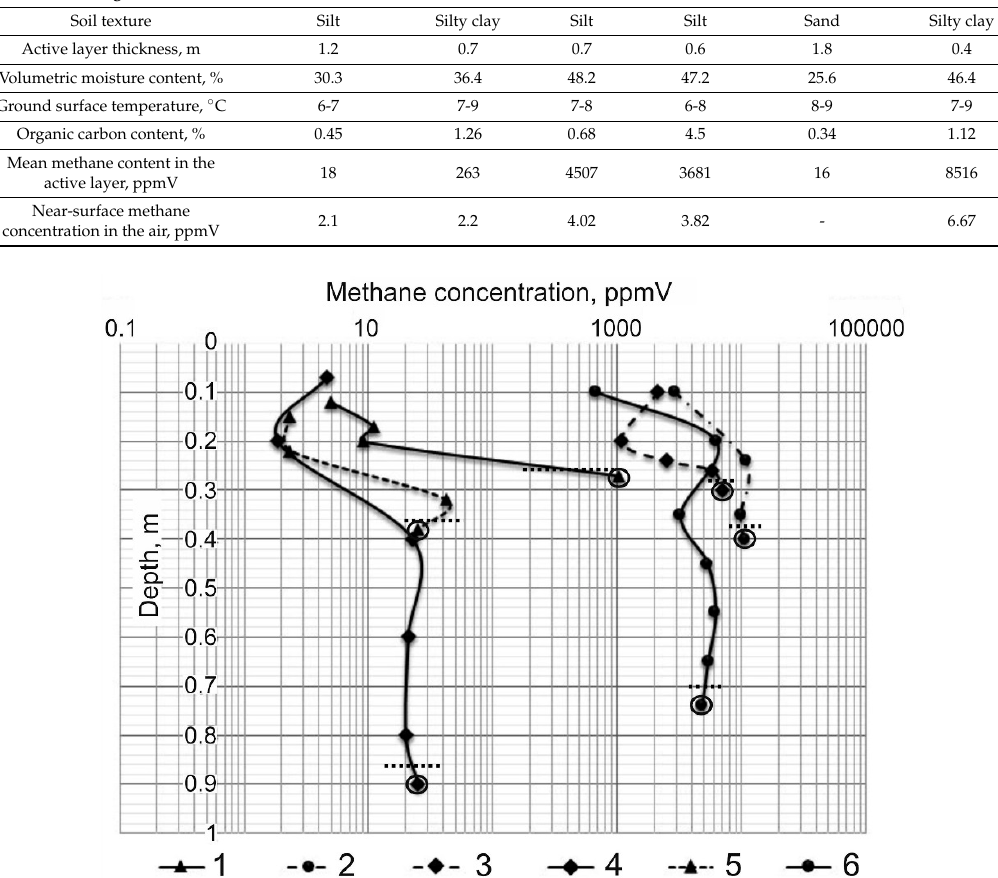
Figure 4. Methane content in the active layer and upper permafrost of the typical landscape units characteristic to the Marre-Sale site (august, 2017): 1—wet tundra; 2—wet polygonal tundra; 3—water tracks; 4—sand blowouts; 5—well-drained tundra; 6—bogs. The horizontal dotted lines show the active layer depths. Samples obtained from frozen soils are marked with circles.